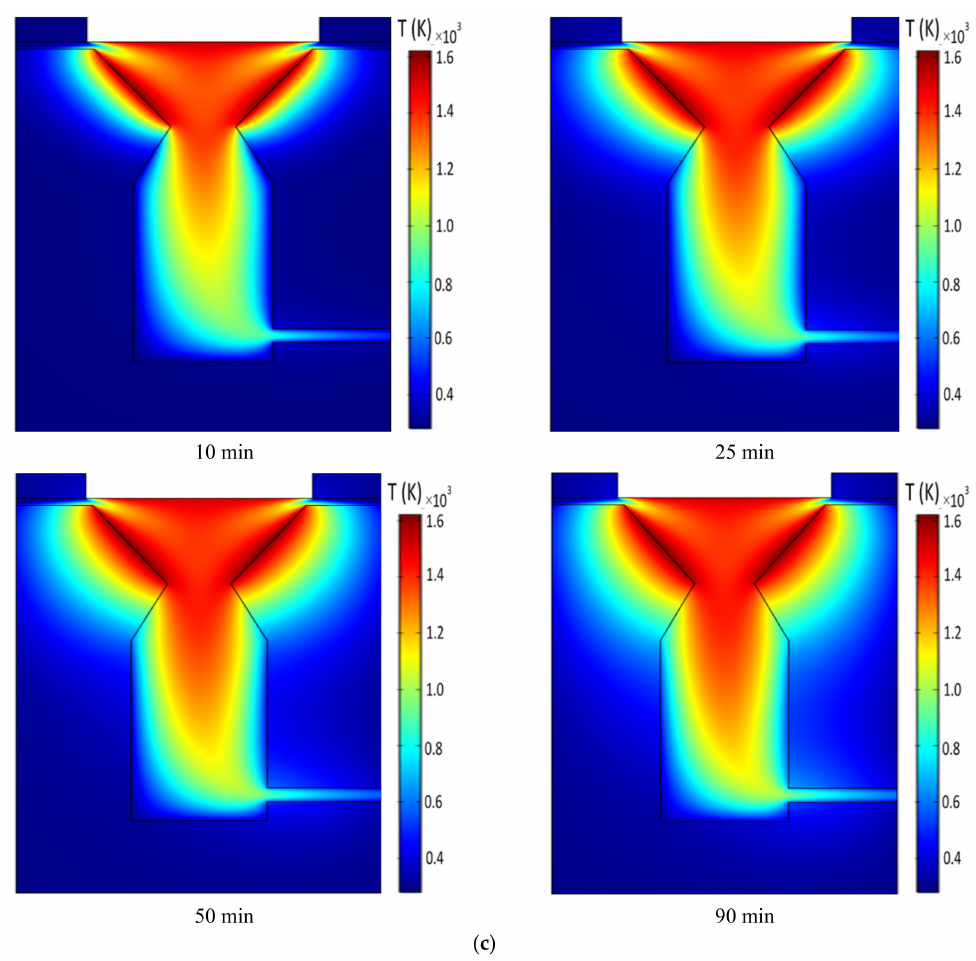
Figure 13. The instantaneous distribution temperature at 150 kW / m 2 , 1 atm and 3.6 L / h: ( a ) Temperature distribution; ( b ) Bar chart illustrating the outlet average and surface average temperatures in the cavity and ( c ) Thermal imagery showing the instantaneous distribution of temperature inside the reactor at di ff erent